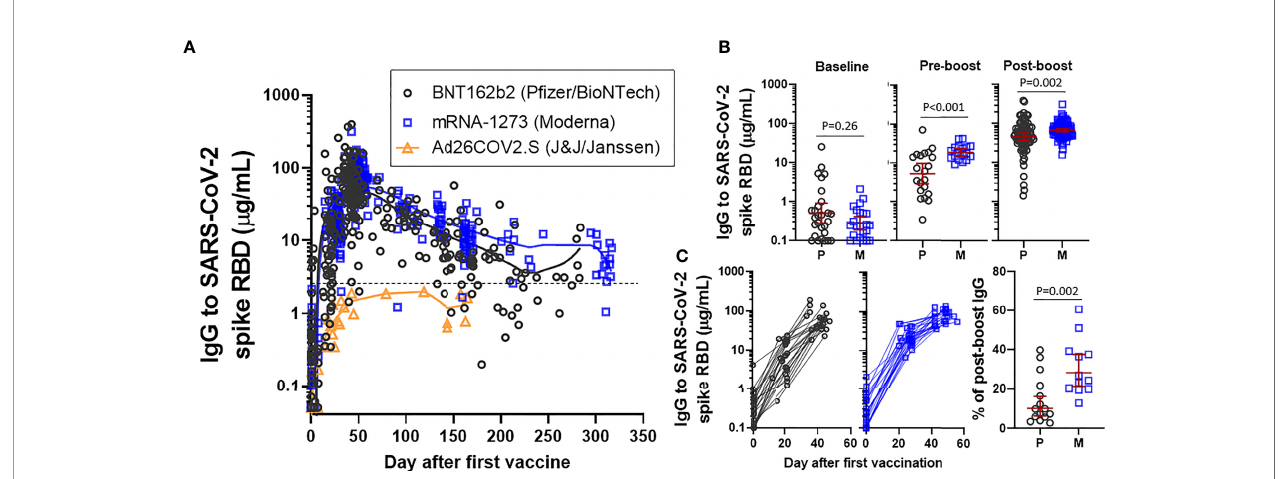
FIGURE 1 | IgG to SARS-CoV-2 spike RBD in an employee cohort. (A) Visualization of IgG levels with LOWESS curves in all samples collected from recipients of BNT162b2 (P fi zer/BioNTech), mRNA-1273 (Moderna) or Ad26.COV2.S (J&J/Janssen). The dashed line re fl ects the cut-off that was originally described for distinguishing positive and negative samples. (B) Comparison of levels at baseline, pre-boost (restricted to samples collected within one day of boost) and post- boost (7-31 days after the boost immunization) in recipients of BNT162b2 (P) or mRNA-1273 (M). Presented as GM with 95% CI and comparisons with Mann- Whitney U test. (C) Longitudinal data from subjects who had a sample at each of a baseline, pre-boost interval and post-boost interval, excluding subjects with prior COVID-19 infection (left). Level of pre-boost IgG as % in relation to post-boost IgG level, in subjects with longitudinal sampling